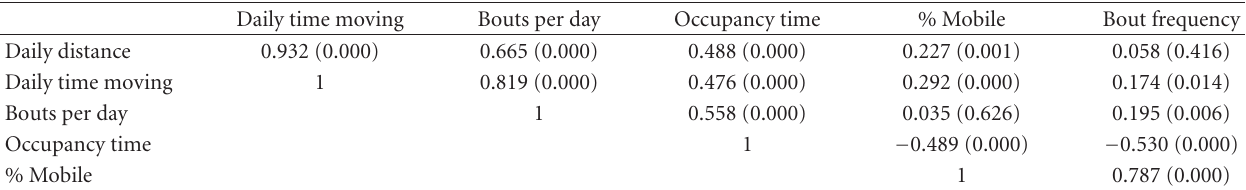
Table 5: Correlations were high between daily distance and time spent wheeling, but lower when comparing metrics with number of bouts or occupancy time. Pearson correlation coe ffi cient ( P -value).